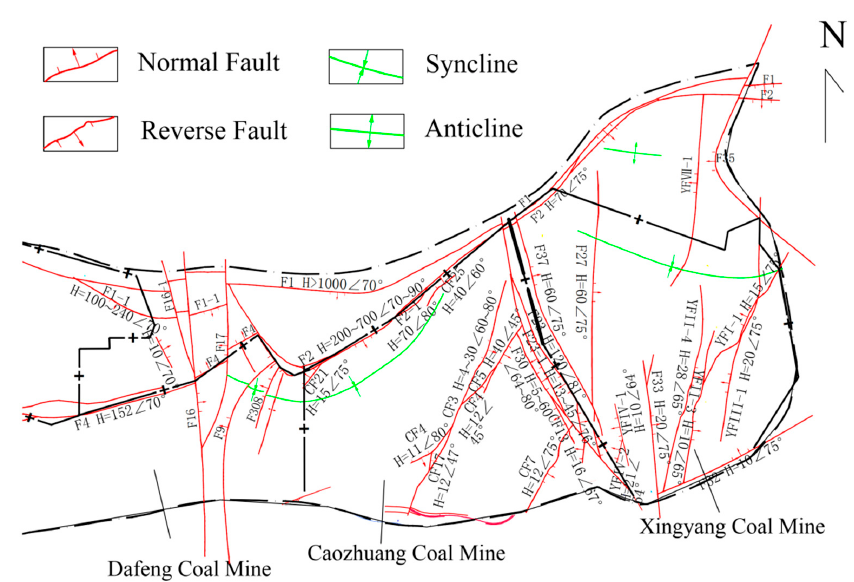
Processes 2018 , 6 , x FOR PEER REVIEW Figure 2. Geological map of Caozhuang Coal Mine. Figure 2. Geological map of Caozhuang Coal Mine.